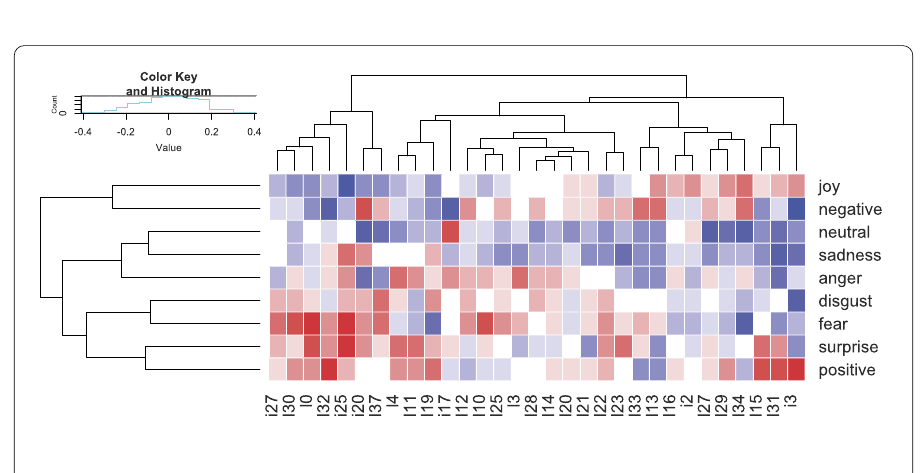
Figure 5 ILI-Affect correlations across 31 military locations. Positive (blue) and negative (red) correlations between ILI visits and tweet affect time series by location. Locations (columns) and affects (rows) grouped by similarity using the Euclidean distance measure are shown as